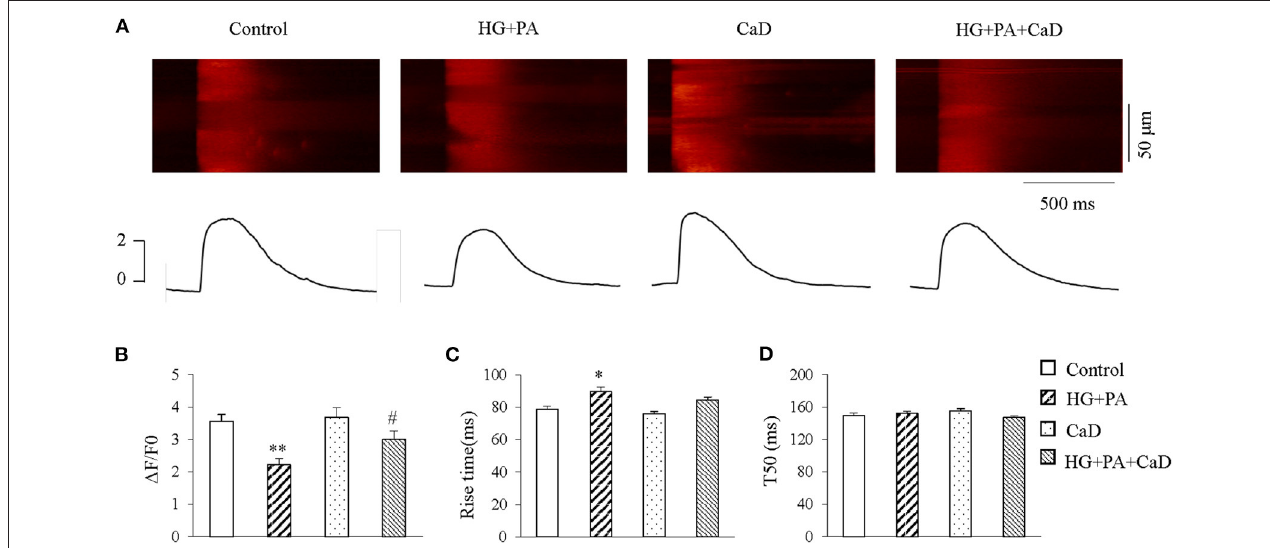
FIGURE 3 | HG + PA reduces systolic Ca 2 + transient in cardiomyocytes. (A) Representative confocal line-scan images of Ca 2 + transients ( upper panels ) along with the spatial average ( lower panels ) in Control, HG + PA, CaD, and HG + PA + CaD treatments. (B–D) Average amplitudes ( 1 F/F0, B ), Rise time (C) and half time of decay (T 50 , D ) of Ca 2 + transient in Control, HG + PA, CaD, and HG + PA + CaD treatments. ** p < 0.01, * p < 0.05 vs. control; # p < 0.05 vs. HG + PA. n = 25–45.